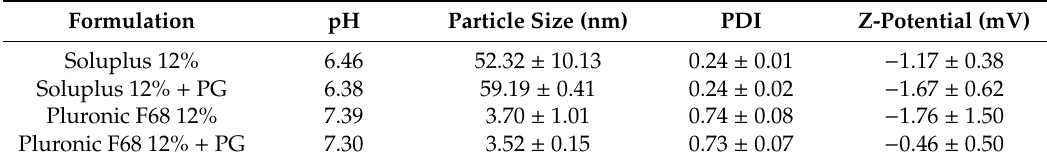
Table 1. pH, particle size (number distribution), polydispersion index (PDI), and Z-potential (mV) of Soluplus and Pluronic (12%) micelles in a PBS pH 7.4 at 25 ◦ C before and after being loaded with progesterone (PG). Mean values ± standard deviations; n =